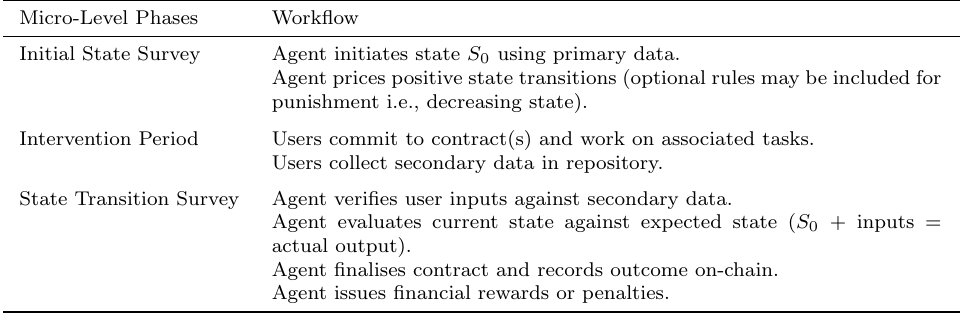
Table 3: The contractual agreement workflow for the micro-welfare